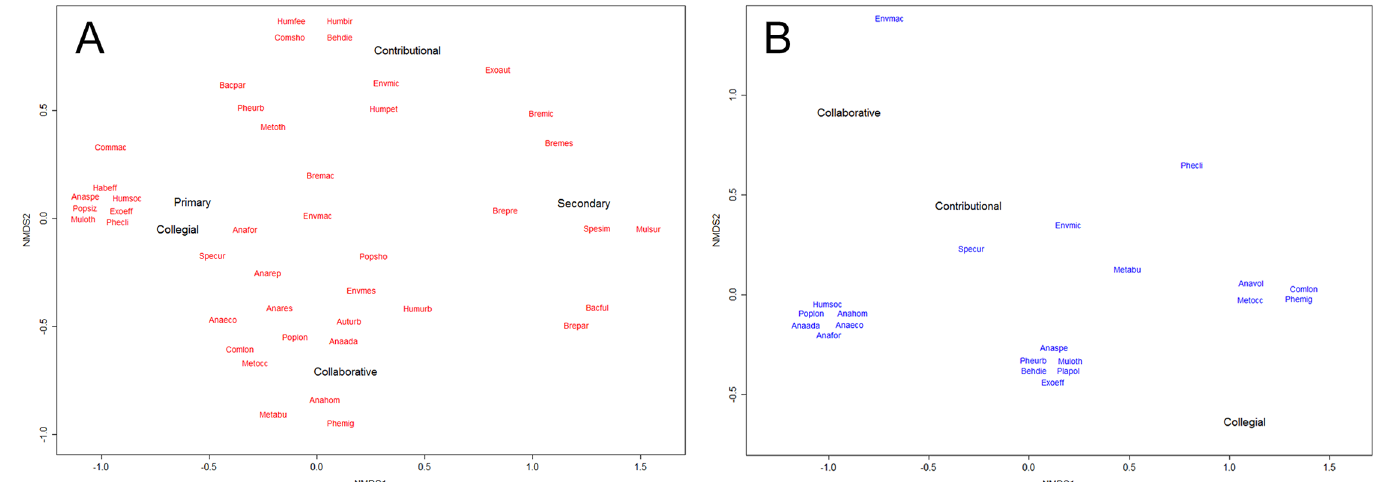
Fig 2. Non-metric multi-dimensional scaling plot suggesting associations between thematic categories and citizen science usage and engagement modes for (a) birds and (b)